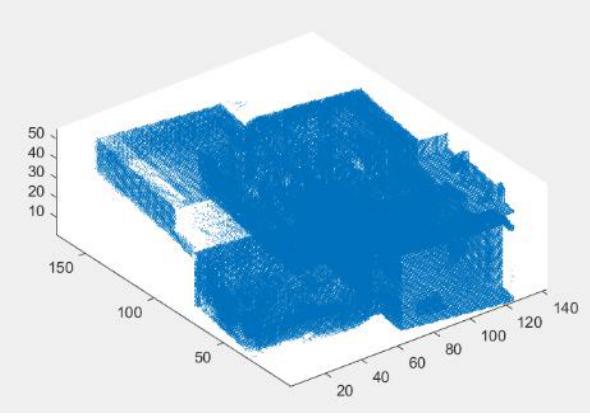
Figure 5. The binary voxel space considering 0.1 m voxel size.